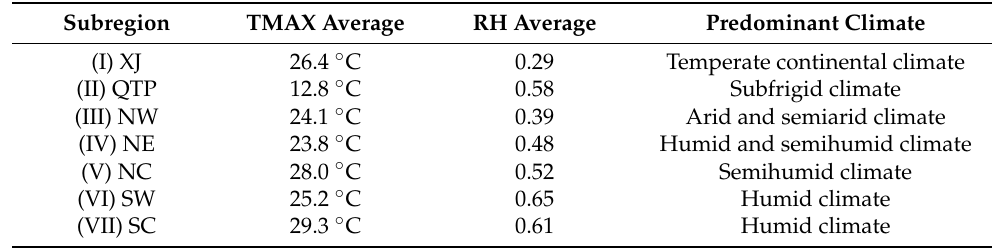
Figure 1. Overview of study area. ( a ) Topographic features of China and subregional divisions: (I) Xinjiang (XJ), (II) Qinghai–Tibetan Plateau (QTP), (III) Northwest (NW), (IV) Northeast (NE), (V) North China (NC), (VI) Southwest (SW), and (VII) South China (SC); POP is ratio between local and total population of China. ( b ) Maximum temperature from May to September during 1979–2018. ( c ) Relative humidity from May to September during 1979–2018. Table 1. Average of max temperature (TMAX) and relative humidity (RH), and predominant climate in seven subregions of